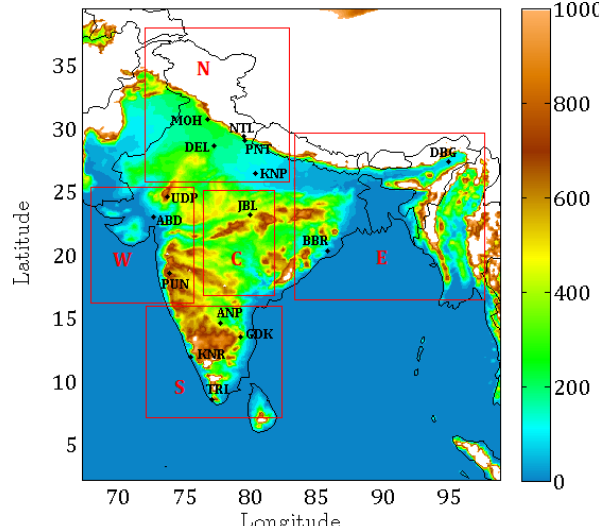
Figure 1. Simulation domain showing terrain height (in metres) and observation sites. The white region indicates that the terrain height is equal to or exceeds 1km. The domain is subdivided into five re- gions, i.e. North (N), south (S), east (E), west (W) and central (C), as shown by red